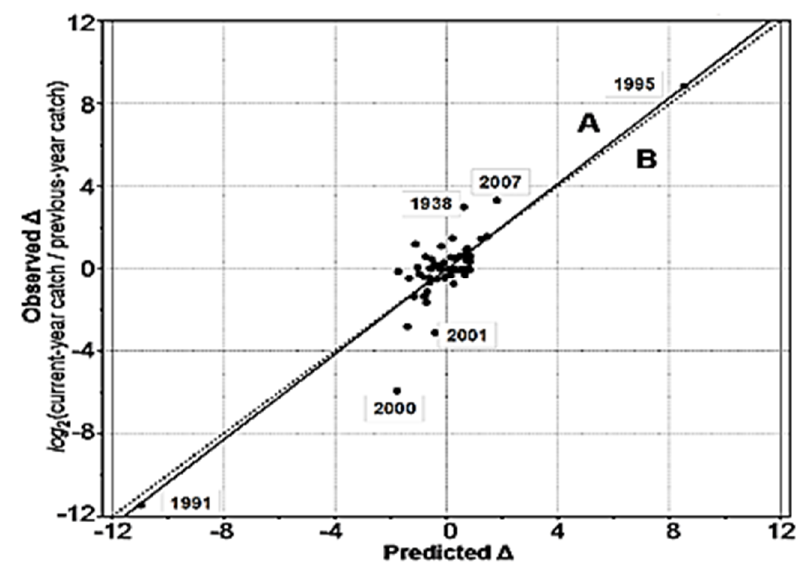
Figure 4. Observed change in logarithmic vendace catch ratio (Δ) compared to the change predicted on the basis of key LSWT parameters. Continuous line (A) fits all the data; dashed line (B) fits data excluding the years 1991 and 1995. The regression line (continuous line A) fits all the data, including data points of the years 1991 (collapse of the vendace population) and 1995 (small recovery). Nevertheless, the dashed line (B) fitted without using the 1991 and 1995 data (p < 0.0001) did not differ practically from line A.